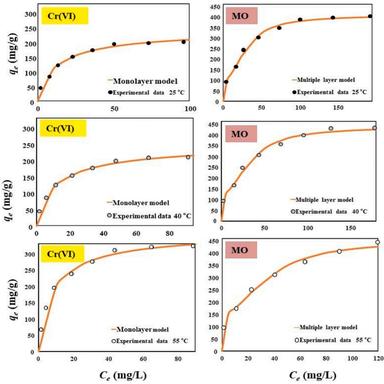
The performance of statistical physics monolayer and multilayer models for the modeling of the adsorption of Cr(VI) and MO on Mus/St/MNPs.